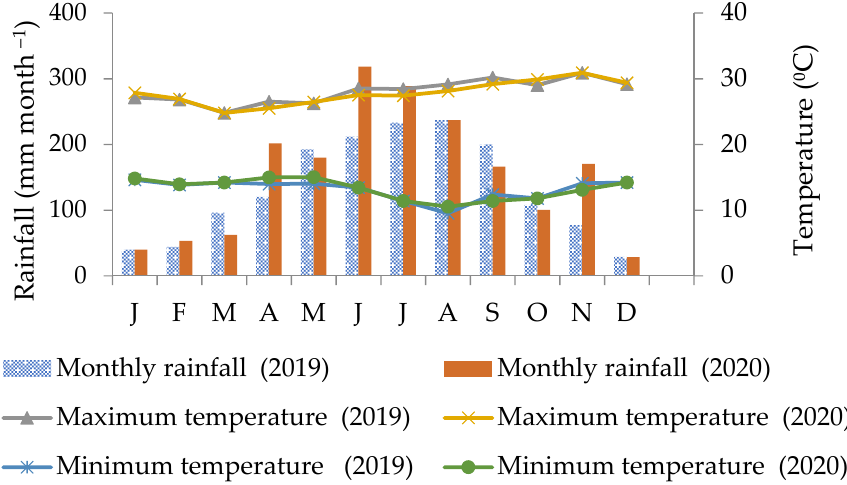
Figure 2. Monthly rainfall and temperature of the study area during the experimental periods 2019 and 2020. Data source: Regional Meteorological Service Agency, Jimma Meteorological Branch Office, Ethiopia.